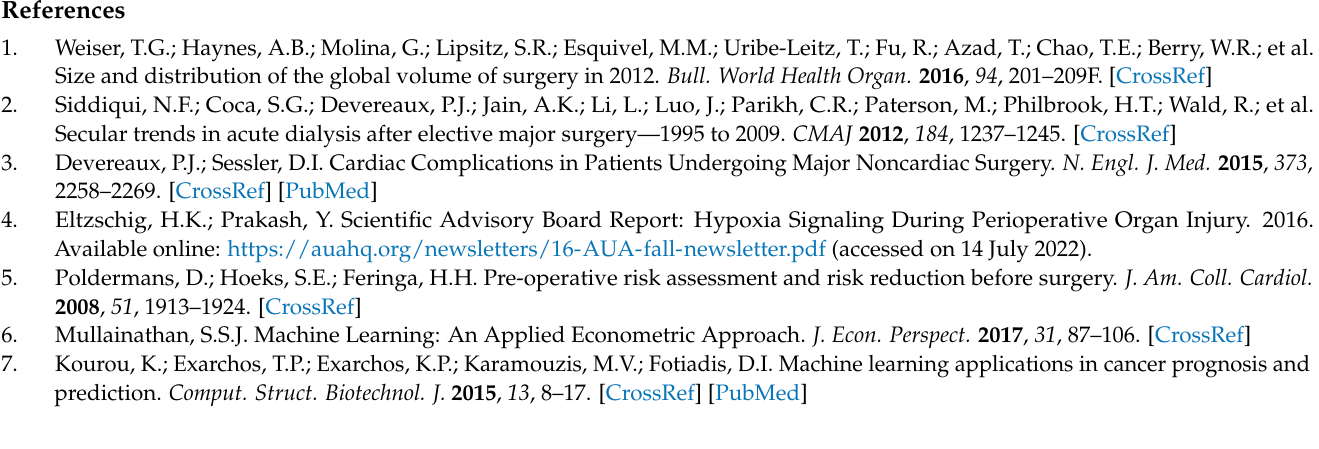
tion dataset (Ajou University Medical Center). Table S2: Performance Metrics of Models. Figure S1: Performance of model in the balanced